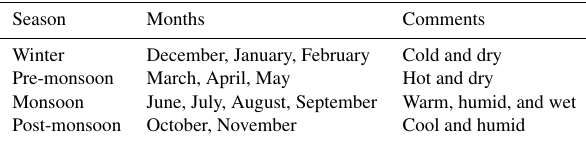
Table 2. Seasons are defined in the analysis and average weather conditions.